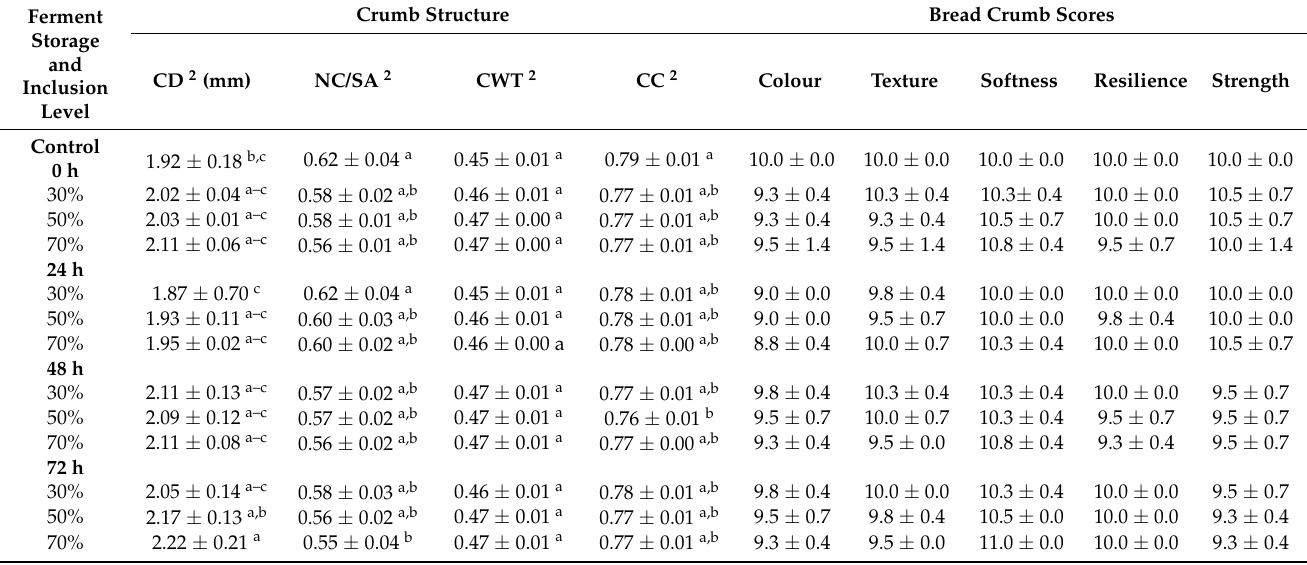
Table 8. Crumb structure parameters and bread scores of the control and breads containing ferment stored for varying periods of time 1